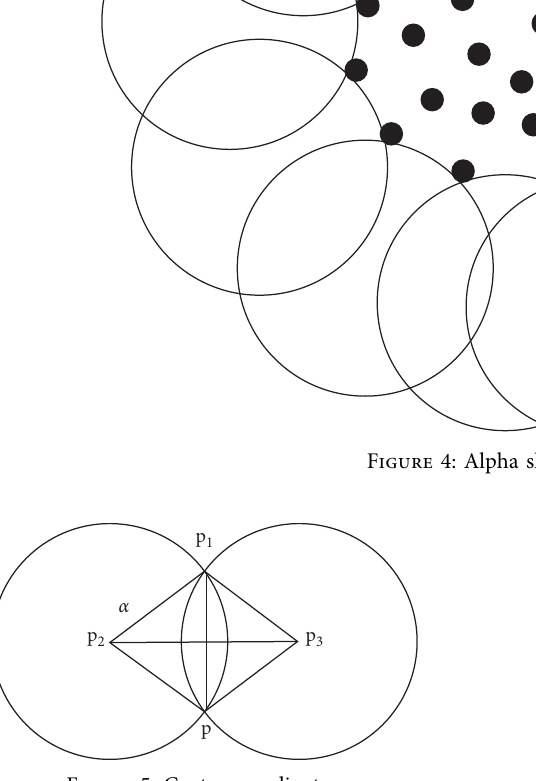
Figure 5: Center